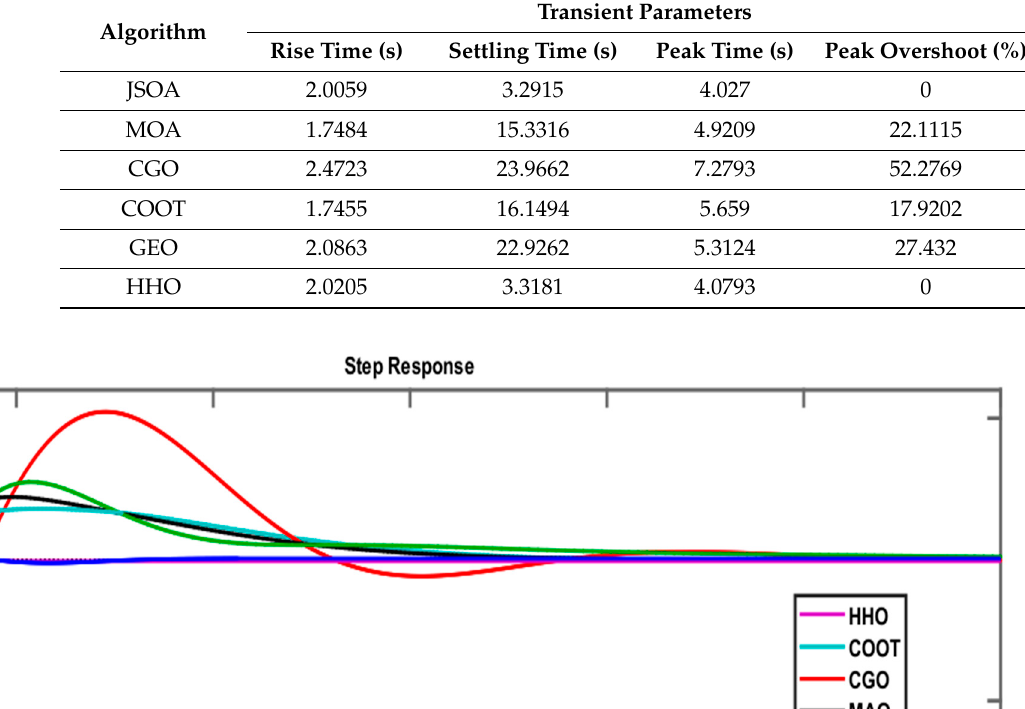
Table 11. Comparison results of transient response parameters.